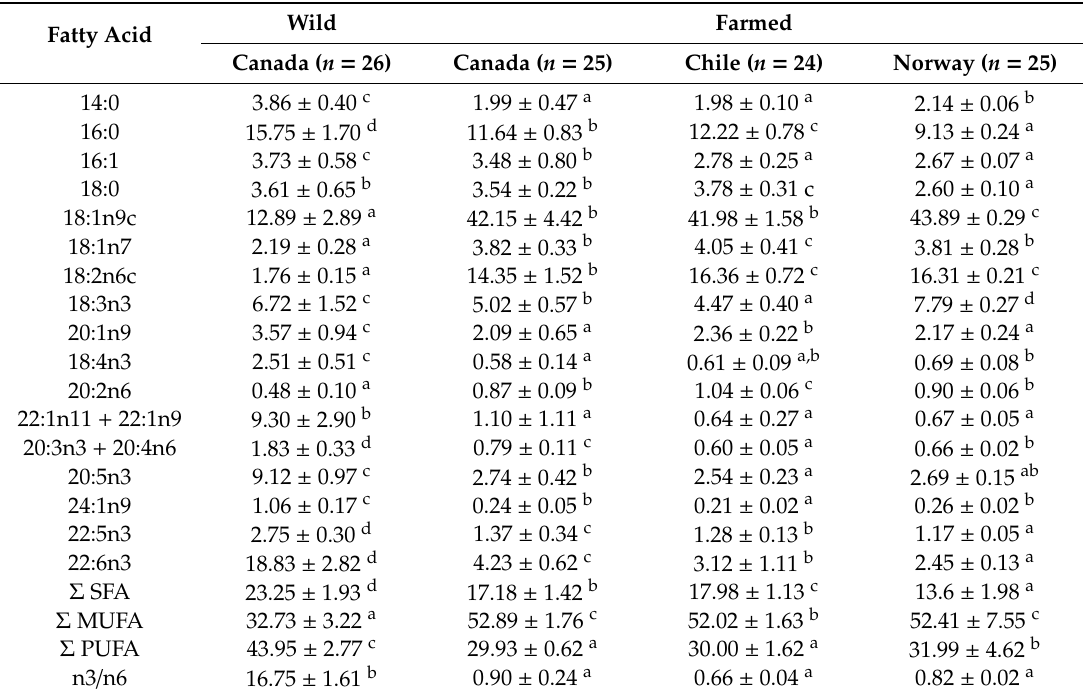
Figure 2. Chromatograms of fatty acid profiles obtained by GC-FID analysis of wild ( A ) and farmed ( B ) salmon samples from Canada. Table 2. Fatty acid composition (relative% of the identified FAME) obtained by GC-FID analysis of lipids from the wild and farmed salmon samples of different origins. Results are given as mean ± SD of the total specimens analyzed for each group.